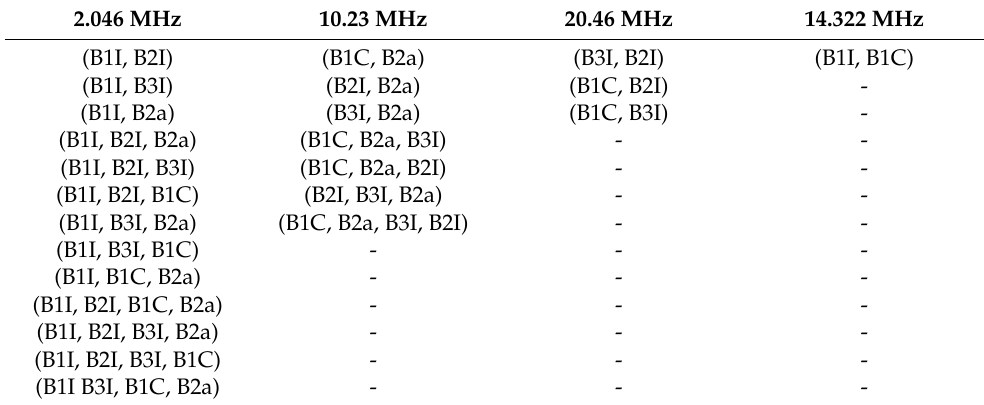
Table 2. The common maximum common factor frequency